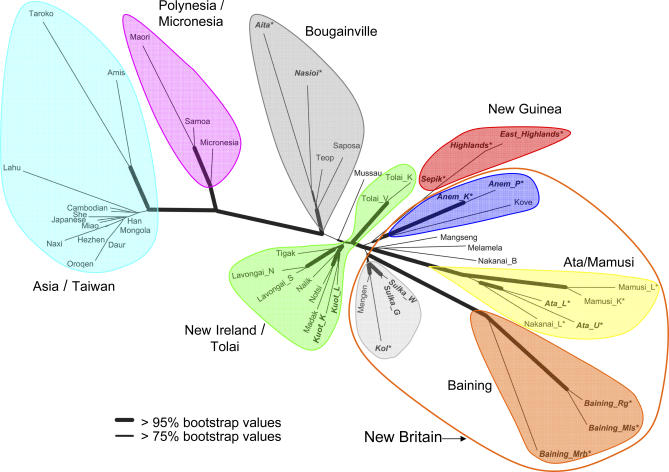
Pacific Population TreeNeighbor-joining F
ST-based tree for 687 microsatellites from the Pacific, East Asia, and French populations, with the range of bootstrap values indicated by branch thicknesses. Colors are the same as in the STRUCTURE analysis at K = 10. New Britain populations are circled. Papuan-speaking groups are in bold italics; inland groups in Melanesia have asterisks. Abbreviated names are spelled out in Table S1.